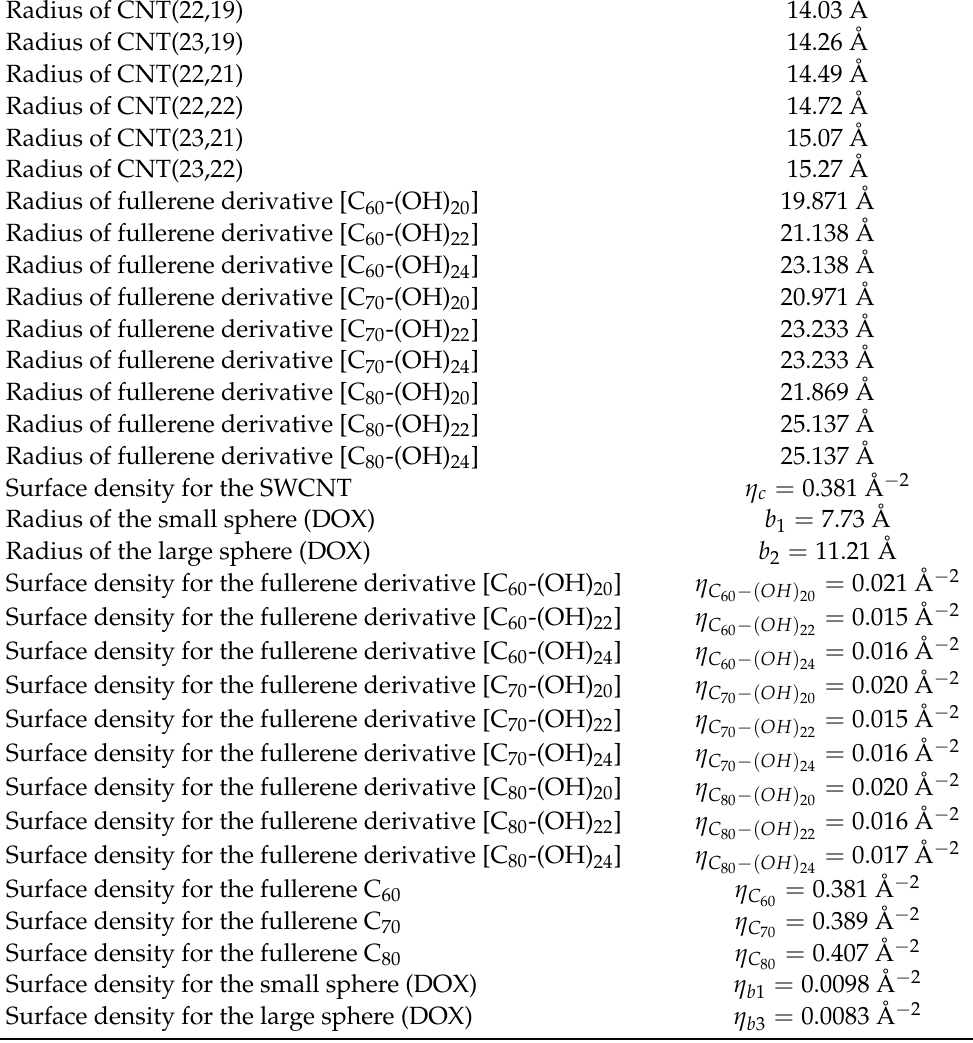
Table 3. Parameters for fullerene derivatives, SWCNTs, and DOX